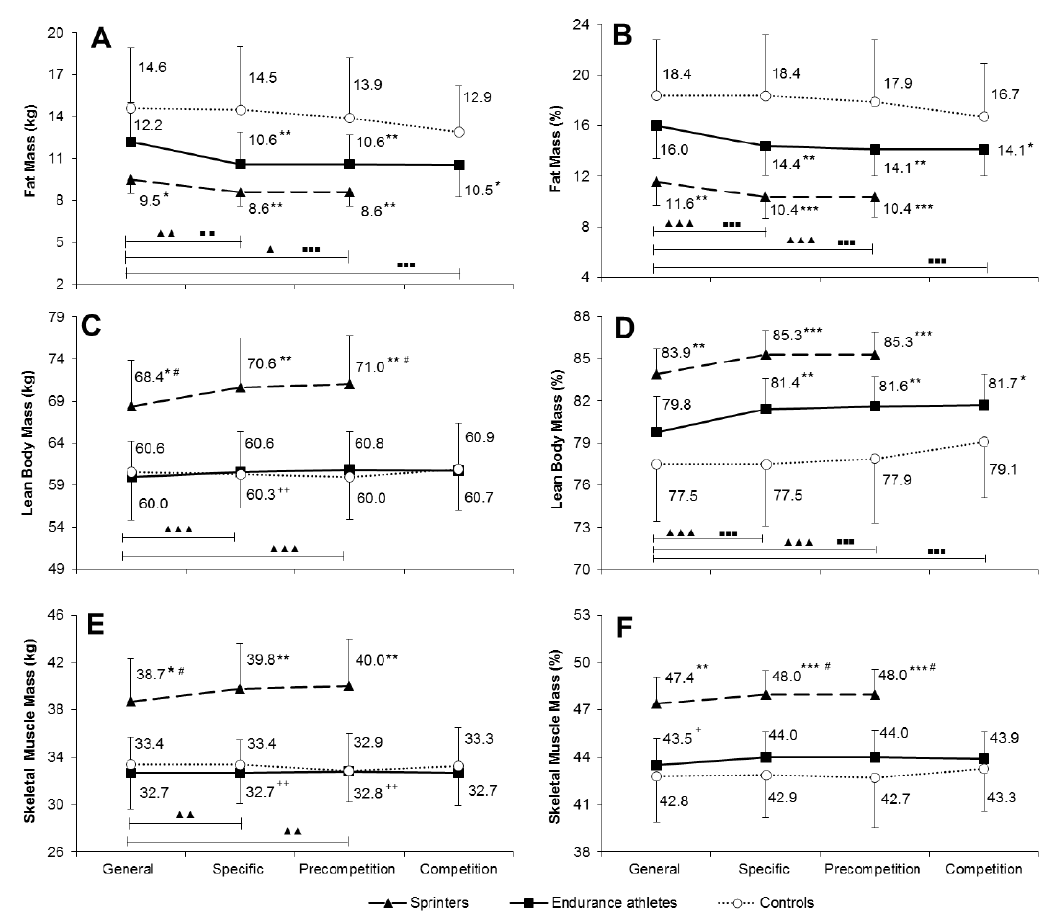
Figure 1. Changes in body composition expressed in absolute and percentage values between consecutive phases of the annual training cycle in athletic groups and controls. Panels ( A , B )—fat mass; Panels ( C , D )—lean body mass; Panels ( E , F )—skeletal muscle mass. ▲ p < 0.05, ▲▲ p < 0.01, ▲▲▲ p < 0.001 — significantly different from the general preparation phase in sprinters; ■■ p < 0.01, ■■■ p < 0.001 — significantly different from the general preparation phase in endurance athletes; + p < 0.05, ++ p < 0.01 — significantly different from sprinters at the same training phase; # p < 0.01 — significantly different from endurance athletes at the same training phase; * p < 0.05, ** p < 0.01, *** p < 0.001 — significantly different from controls at the same training phase.